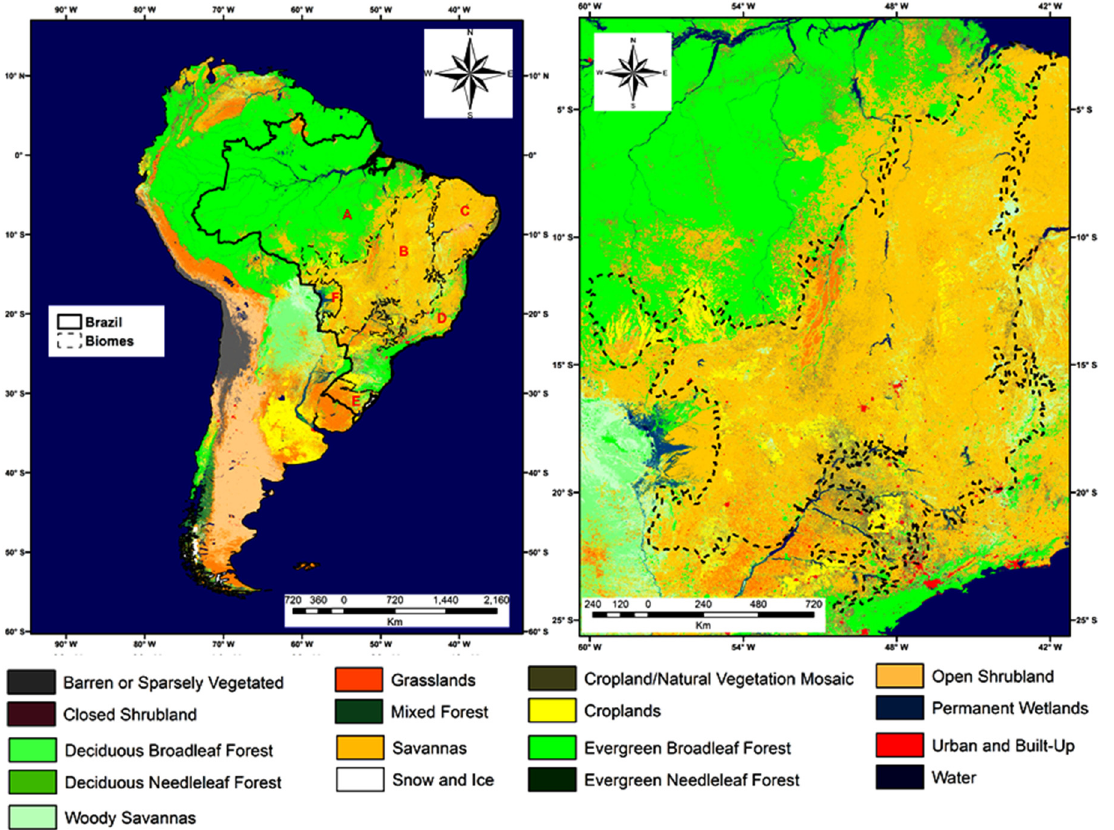
Figure 1. Location of the Cerrado biome in South America (left panel) and in the Brazilian territory (right panel). In the left panel, A represents the Amazon biome, B the Cerrado biome, C the Caatinga biome, D the Atlantic Rainforest biome, E the Pampa biome, and F the Pantanal biome [41]. Base map is Moderate Resolution Imaging Spectroradiometer (MODIS) MCD12Q1 product collection 5.1 for the year 2013 following the International Geosphere-Biosphere Program (IGBP) land cover classification scheme.